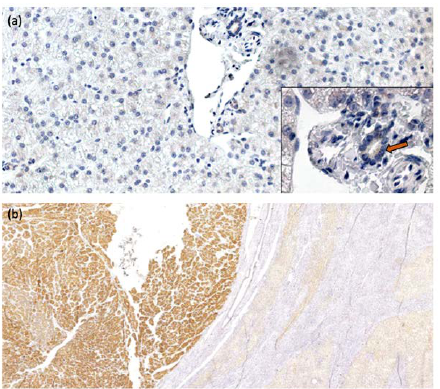
fIguRE 1 – Shh immunoexpression in (a) normal liver, Shh protein is only marked in cholangiocytes (arrow), 200x and 600x magnification; (b) tumoral area (left, strong marking) with pseudoacinar architecture and adjacent cirrhotic nodules (right, moderate marking), 40x magnification.